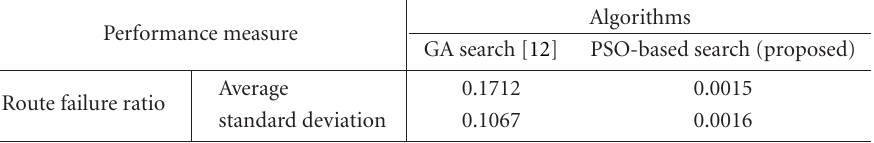
Table 4 . 2 . Comparison of statistics of the quality of solution.